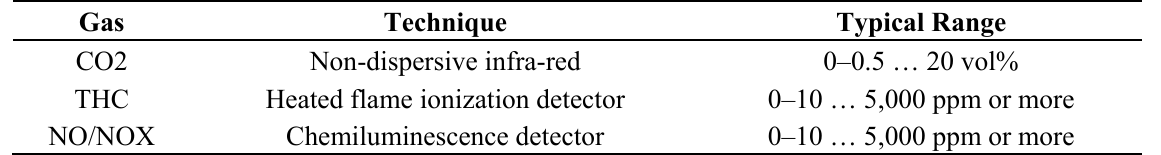
Table 3. Specifications of emission measurement